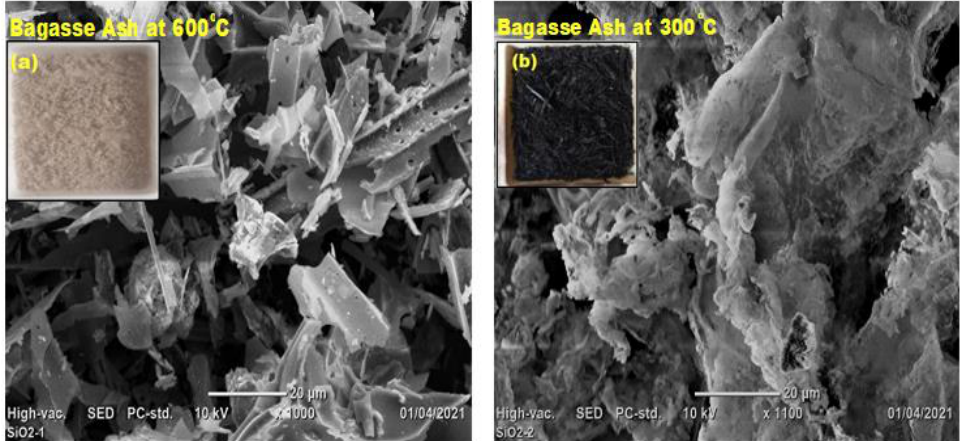
Figure 5. SEM images: ( a ) bagasse ash at 600 °C/2 h; ( b ) bagasse ash at 300 °C/2 h.